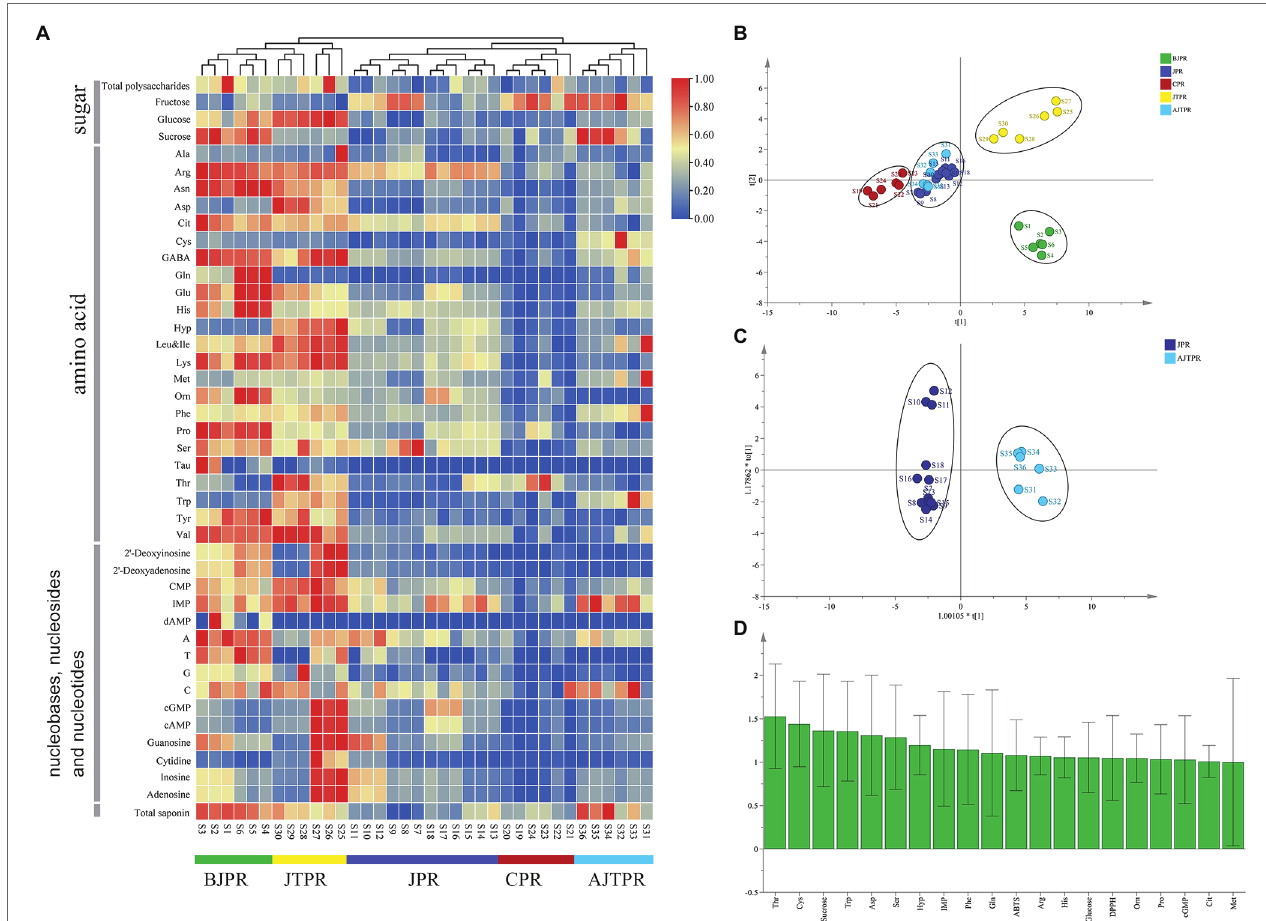
FIGURE 4 | Heatmap cluster analysis and multivariate statistical analysis (A) Hierarchical clustering analysis heat maps, (B) PLS-DA score plot, (C) OPLS-DA score plot, and (D) the VIP plot. BJPR, “ BaiJi -type” Polygonati rhizoma; JPR, “ Jiang -type” Polygonati rhizoma; CPR, “ Cylinder -type” Polygonati rhizoma; JTPR, “ JiTou - type” Polygonati rhizoma; and AJTPR, atypical “ JiTou -type” Polygonati